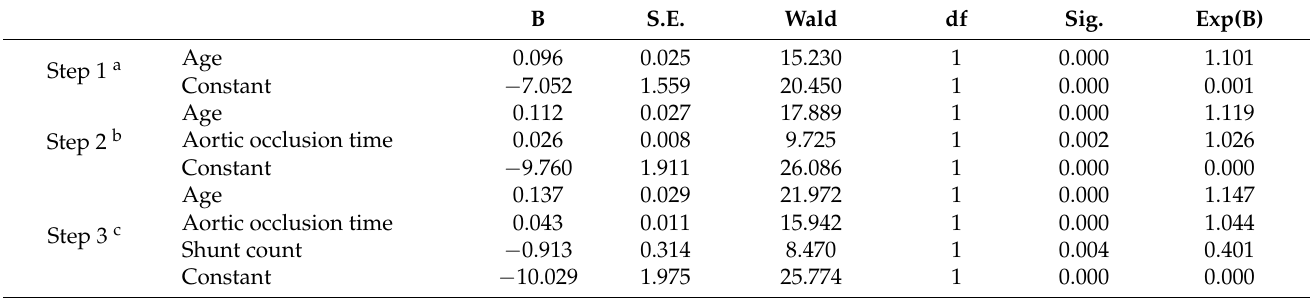
Table 6. Factors associated with the development of this composite endpoint-2 (significant periopera- tive complications) after CABG (binary logistic regression analysis, forward LR method).